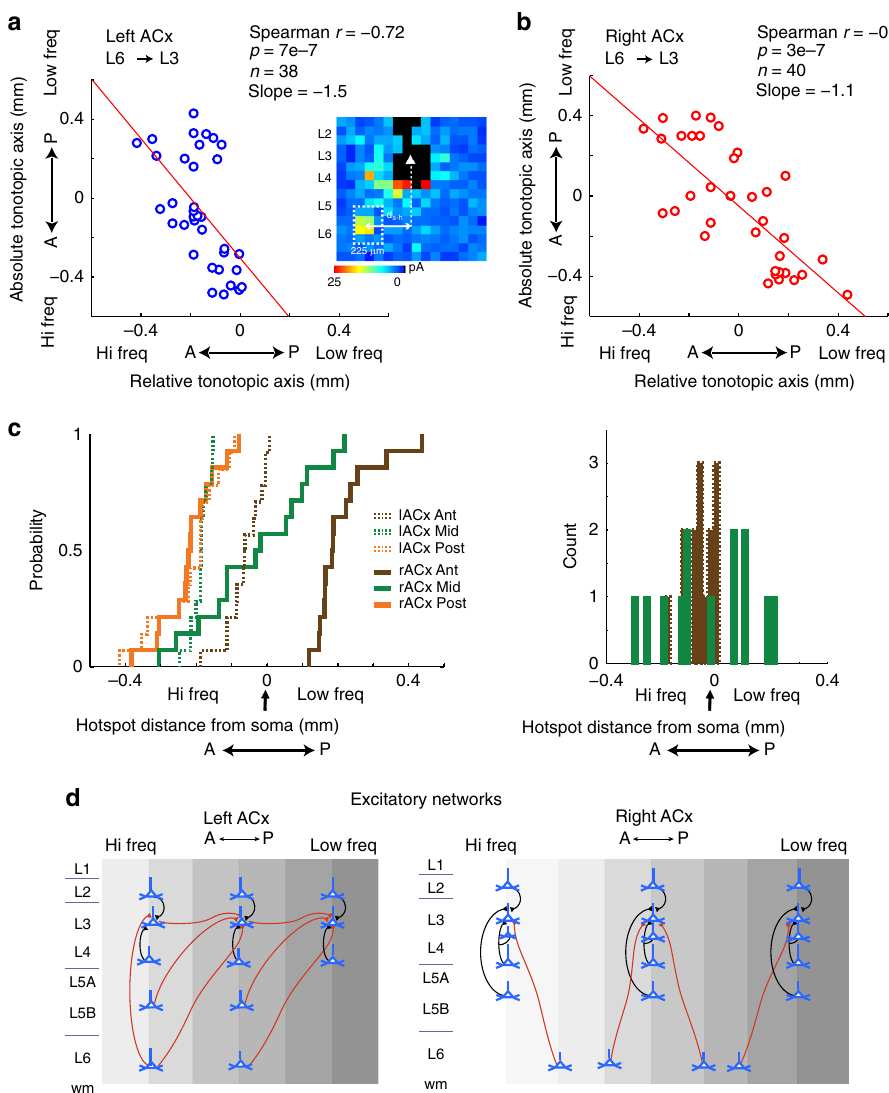
Fig. 4 Lateralized circuit-motifs in the left and right ACx. a , b Population scatter plot pairing each cell ’ s absolute tonotopic position ( y axis) with the relative tonotopic location of its L6 hotspot centroid ( x axis), for the left and right ACx, respectively. Red line is the best linear fi t through the data. Inset depicts a single-cell average input showing how the distance from the soma to the hotspot centroid was calculated. In the y axis, 0 represents the tip of the hippocampus, and in the x axis, 0 is the position of the cell in the LSPS map grid. c , left Intra and interhemispheric cumulative probability density function of L6 → L3 hotspot distance from soma in anterior (brown), middle (green) and posterior (orange) clusters in the left (dashed) and right (solid) ACx. c , right Distribution of L6 → L3 hotspots from anterior sites in the left ACx (dashed brown bars) and middle sites in the right ACx (green bars). d Wiring diagram of excitatory networks in the left ACx and right ACx. Black lines represent columnar projections, and red lines represent out-of-column